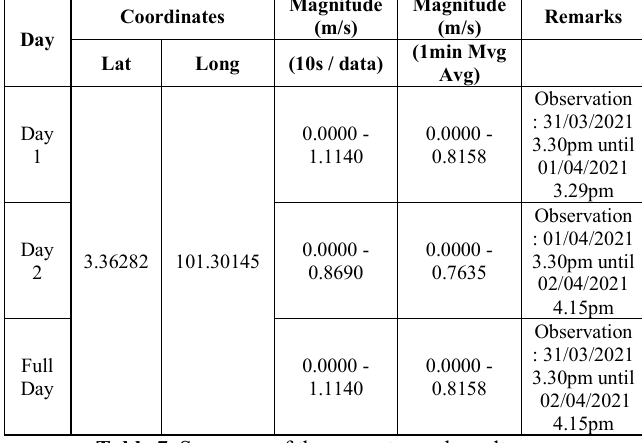
Table 7. Summary of the current speed